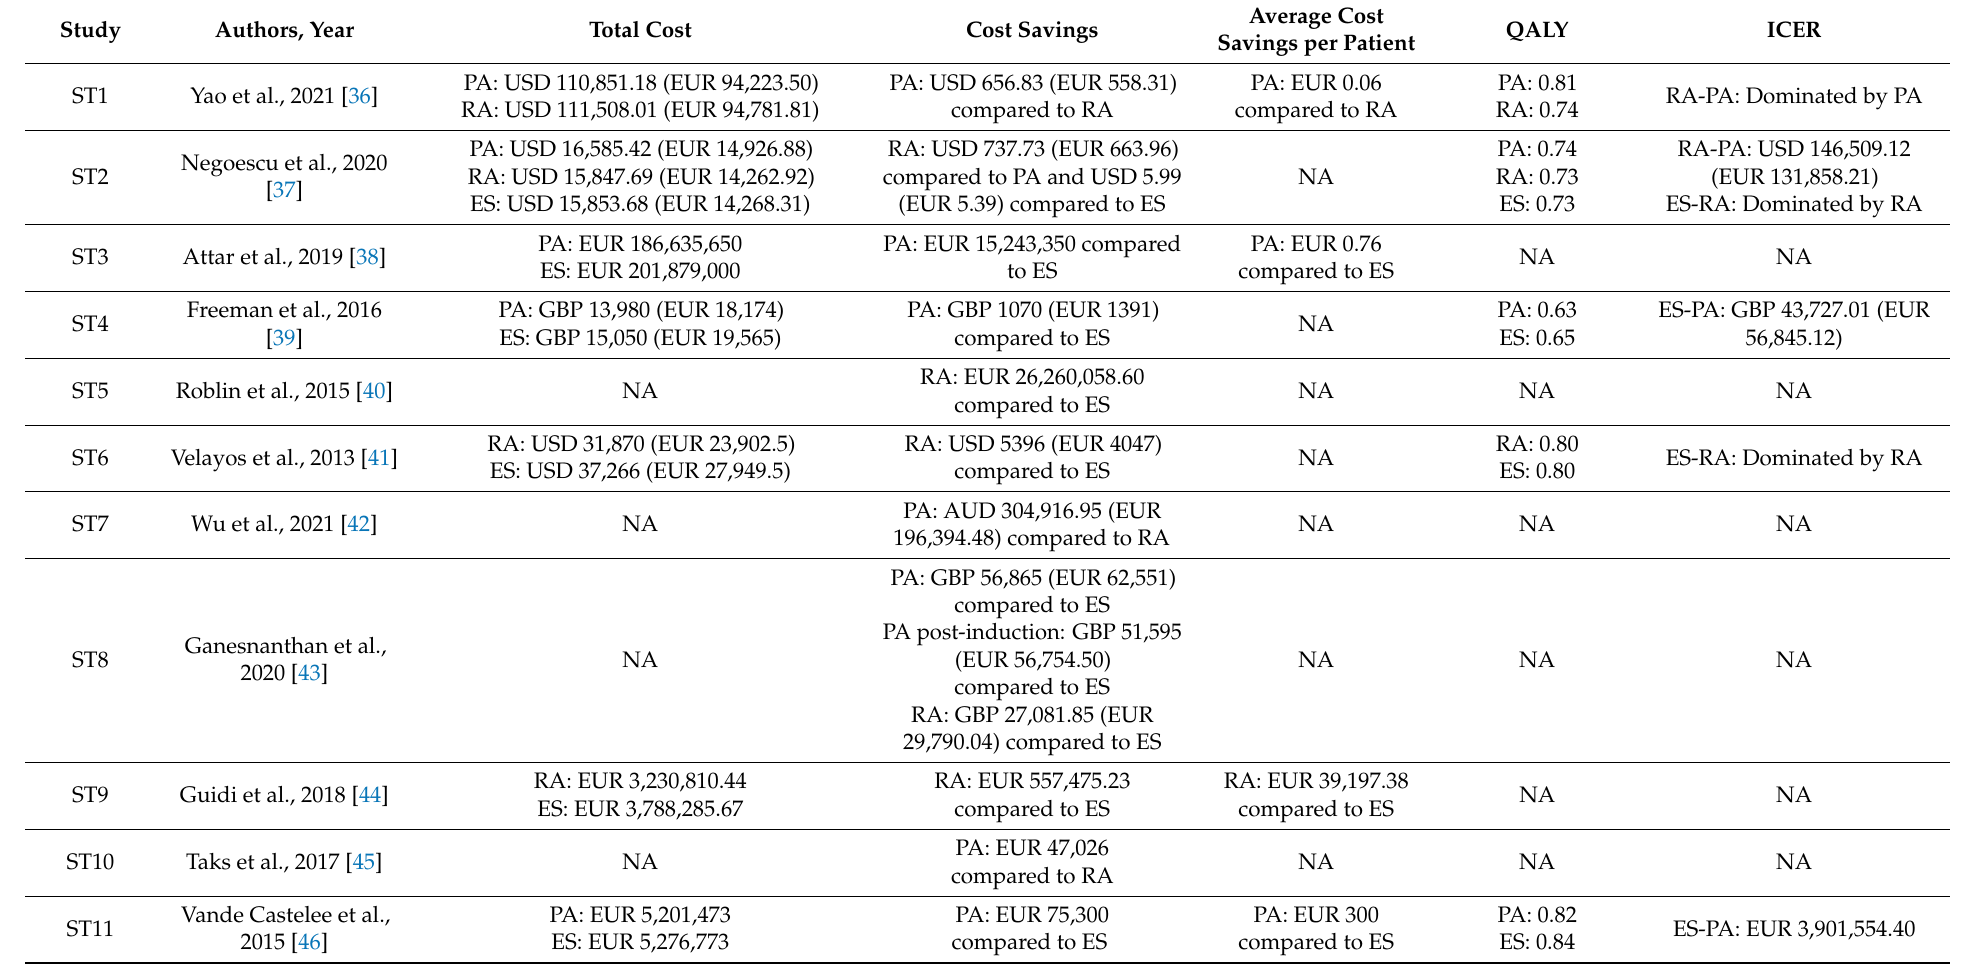
Table 2. Summary of the economic outcomes of each study per